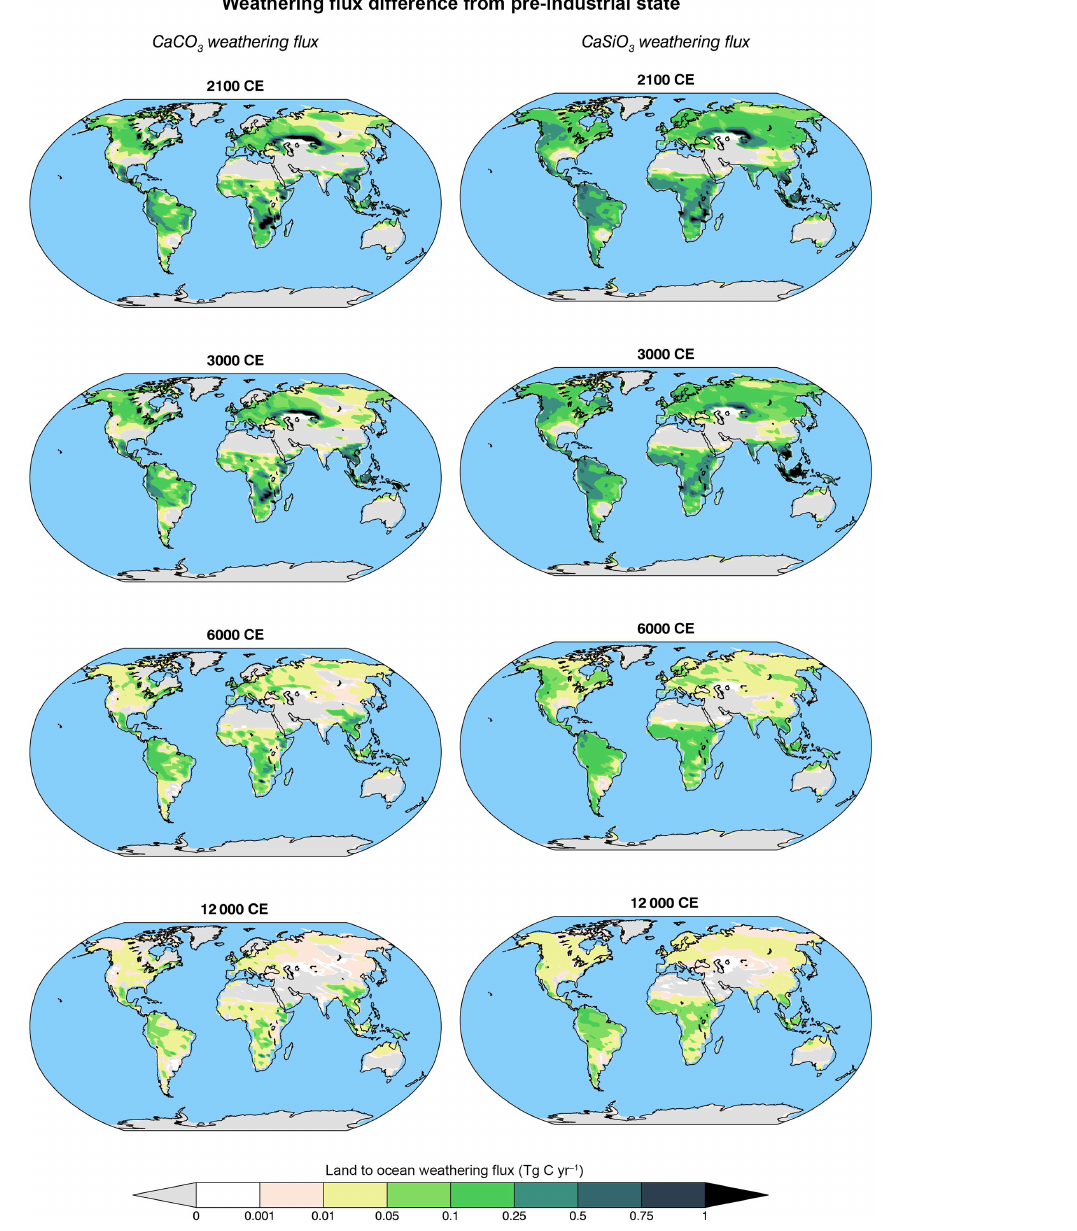
Figure 5. Spatial distribution of changes in carbonate (CaCO 3 ) and silicate (CaSiO 3 ) weathering for experiment A0 from pre-industrial (year 1800CE) steady state to years 2100, 3000, 6000, and 12000CE. Note the nonlinear color scale, used to better display values during the later stages of the model